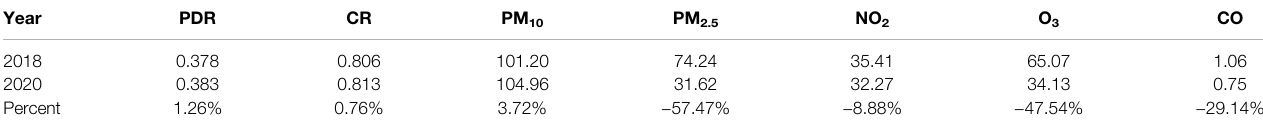
TABLE 2 | Changes in the optical properties of the dust aerosols and the local air quality in East China on March 18, 2018 and March 20, 2020. Year